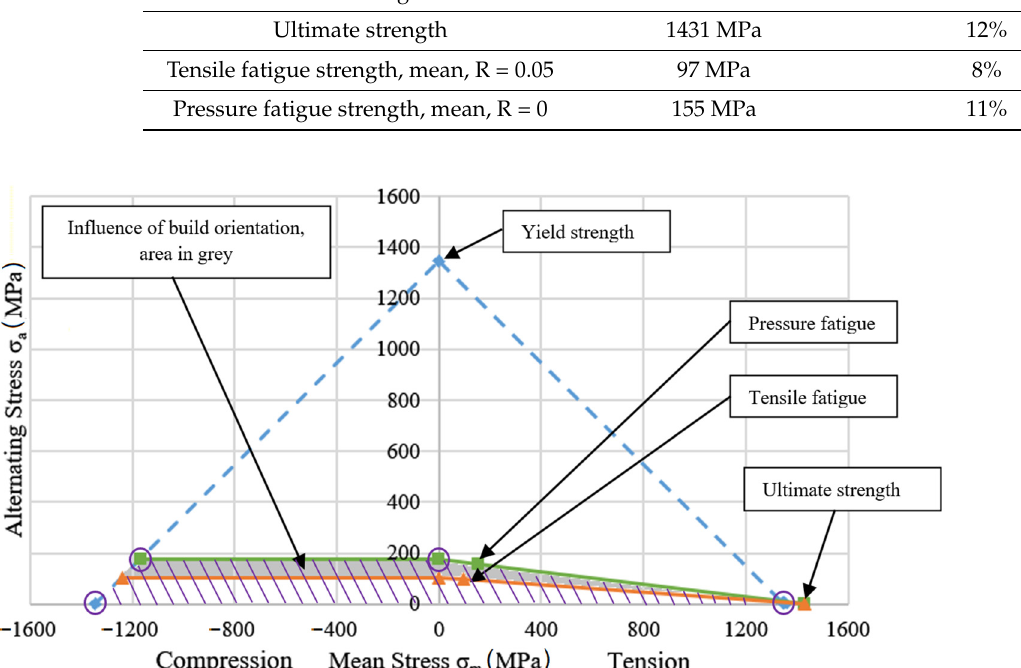
Figure 8. Goodman diagram obtained from fatigue and static testing of the maraging steel specimens produced by SLM.